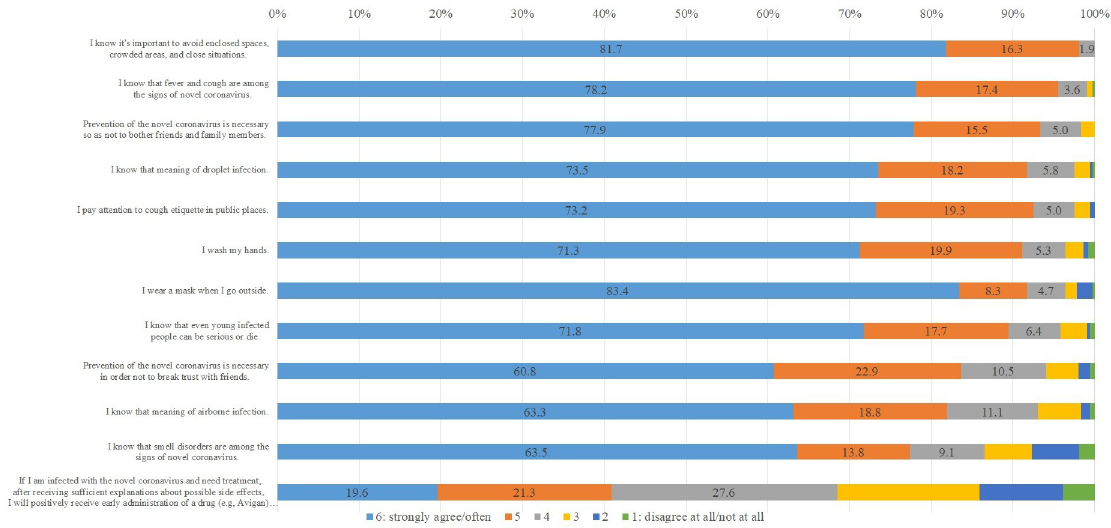
Fig 1. Questions obtaining high safety and good health answers (n =